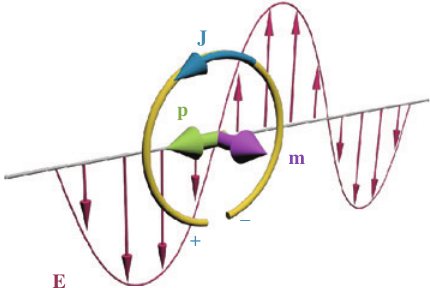
Figure 1: A metal split-ring resonator positioned in the electric field distribution E of a standing wave. Since the resonator size is ext comparable to the wavelength, the induced polarization current J is nonlocal, i.e. depends on the external field in the whole volume occupied by the resonator. Due to the geometry of the split ring, electric field excites both the electric p and magnetic m